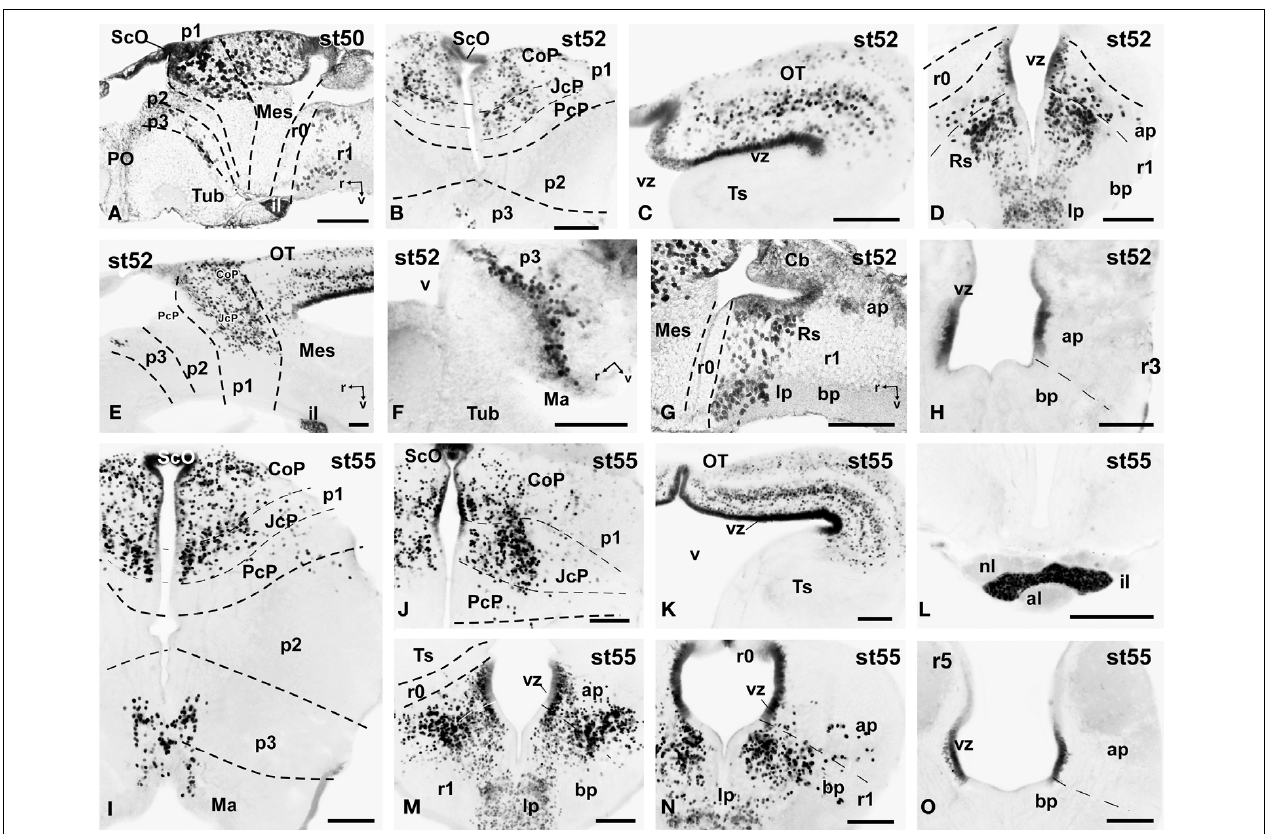
FIGURE 6 | Photomicrographs of single-stained sagittal (A,E-G) and transverse (B–D, H-O) sections through the brain of Xenopus laevis showing the localization of Pax7 cells. Different stages (indicated in the upper right corner of each photomicrograph) corresponding to premetamorphic (A–H) and prometamorphic (I–O) tadpoles are illustrated. All